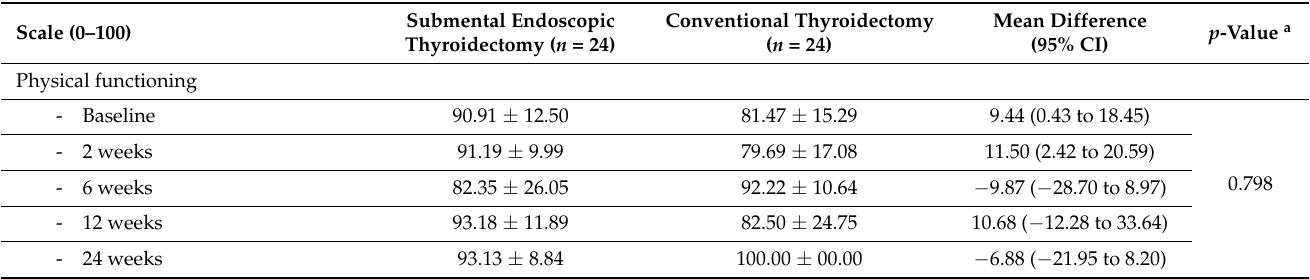
Table 4. General quality-of-life